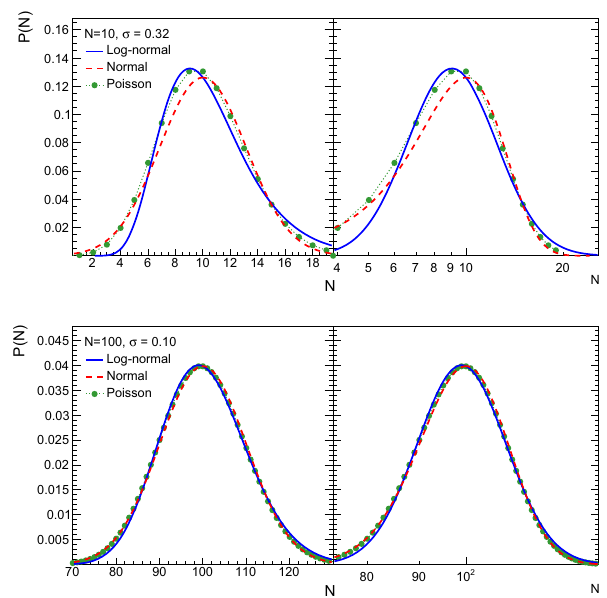
Fig. 3 The log-normal, normal, and Poisson probability distribution functions with mean values of 10 (left) and 100 (right) on a linear and logarithmic axis. These values are commonly referred to as relative uncertaintiesof32%and10%,respectively.Forlargeruncertainties,the log-normal distribution provides a good approximation of the Poisson distribution around the peak. The log-normal and the Poisson distribu- tions are strictly positive. For large N , all distributions become